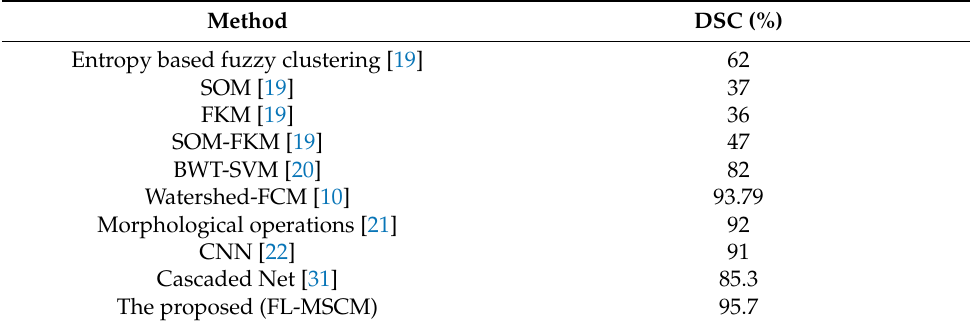
Table 14. Segmentation performance of the proposed and existing